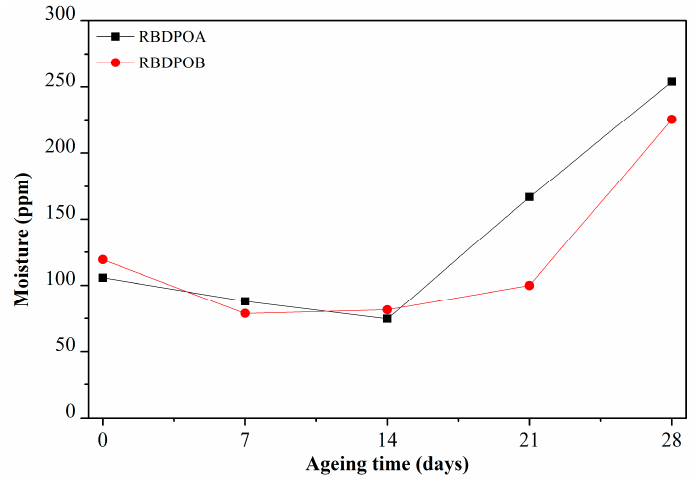
Figure 1. Moisture of refined, bleached, and deodorized palm oil (RBDPO) aged at 170 °C under open conditions.